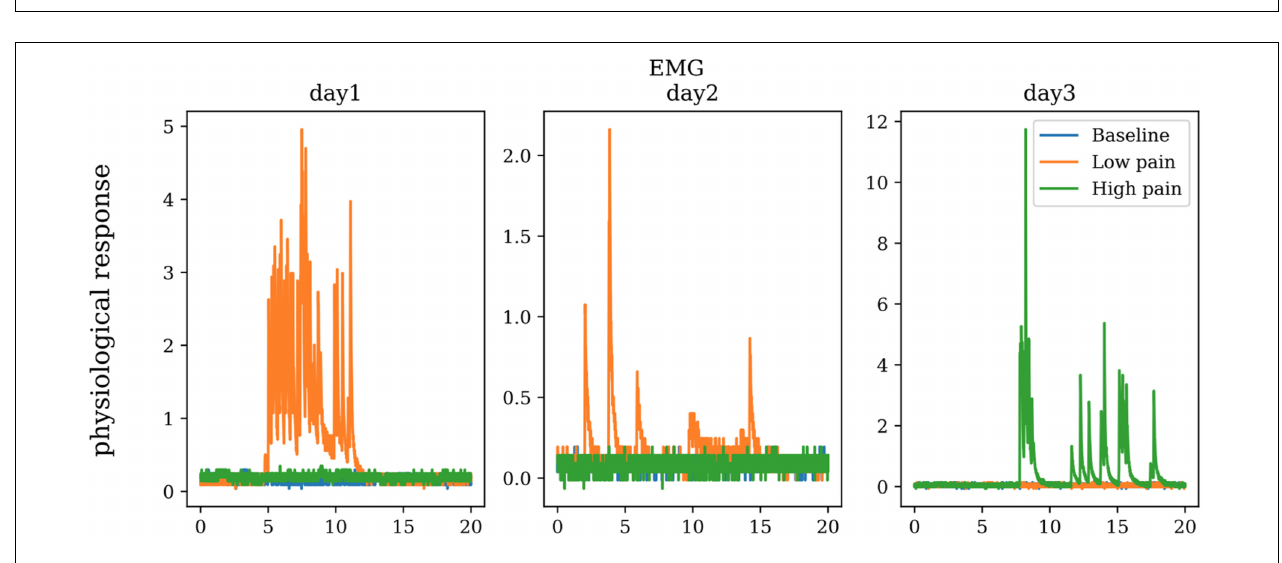
FIGURE 8 | The heart rate of one subject on three repeated days.